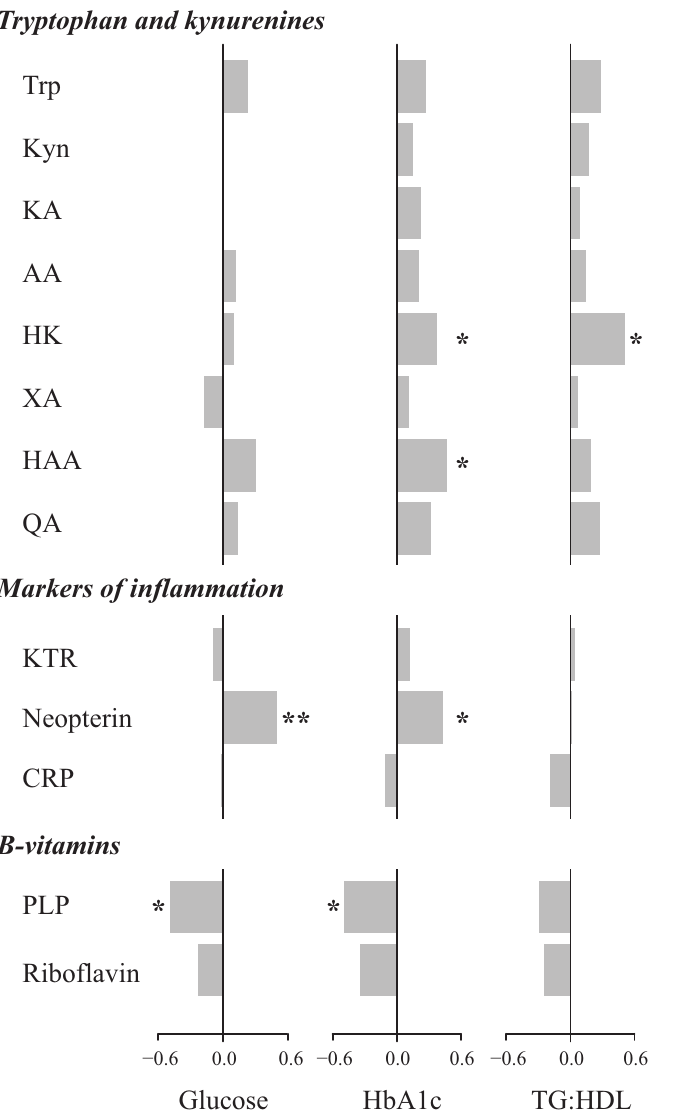
Fig 2. Correlations of fasting glucose, HbA1c and the triglyceride:HDL ratio with tryoptophan, kynurenine and the kynurenine metabolites, inflammatory markers, vitamin B6 and vitamin B3 at baseline. Regression coefficient based on Spearman rank correlation test, corrected for age, gender and eGFR, are shown in the figure. Tg, triglyceride; HDL, high density lipoprotein; Trp, tryptophan; Kyn, kynurenine; KA kynurenic acid; AA, anthranilic acid; HK, 3-hydroxy kynurenine; XA, xanthurenic acid; HAA, 3-hydroxy anthranilic acid; QA, quinolinic acid; KTR, kynurenine:tryptophan ratio; PLP, pyridoxal 5‘-phosphate. (cid:3) p-value < 0.05; (cid:3)(cid:3) p-value <